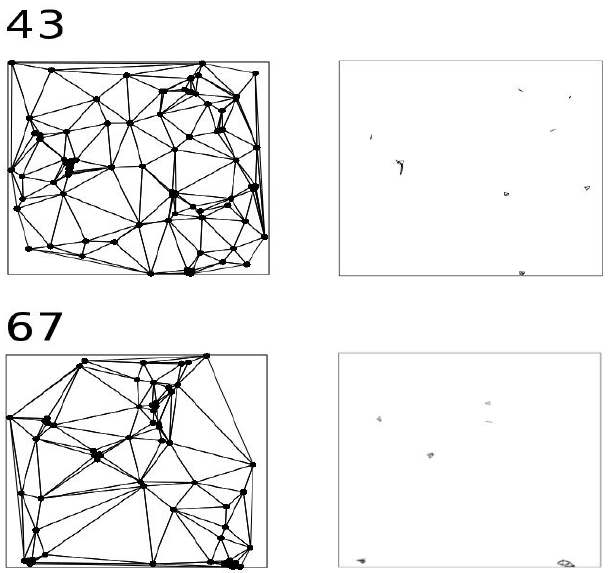
Figure 1. Different steps of the nearest neighbour index clustering (NNIC) process. The left column of the maps correspond to the Delaunay polygons of two point processes (number 43 and 67; see Table S1); and the right column represent the selected triangles.